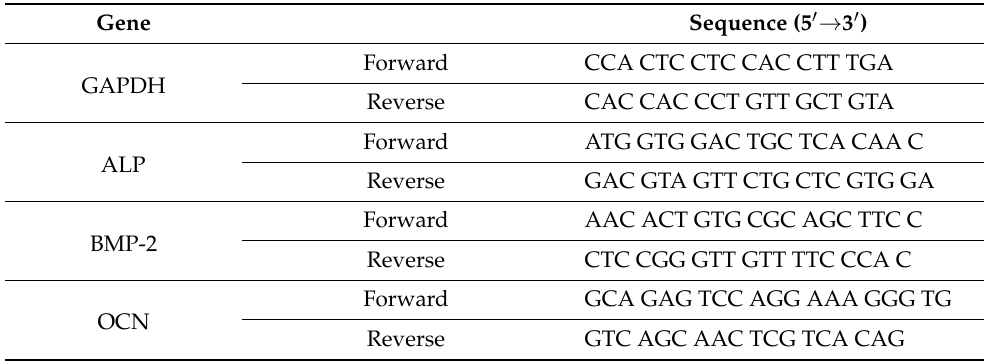
Table 1. The sequence of each